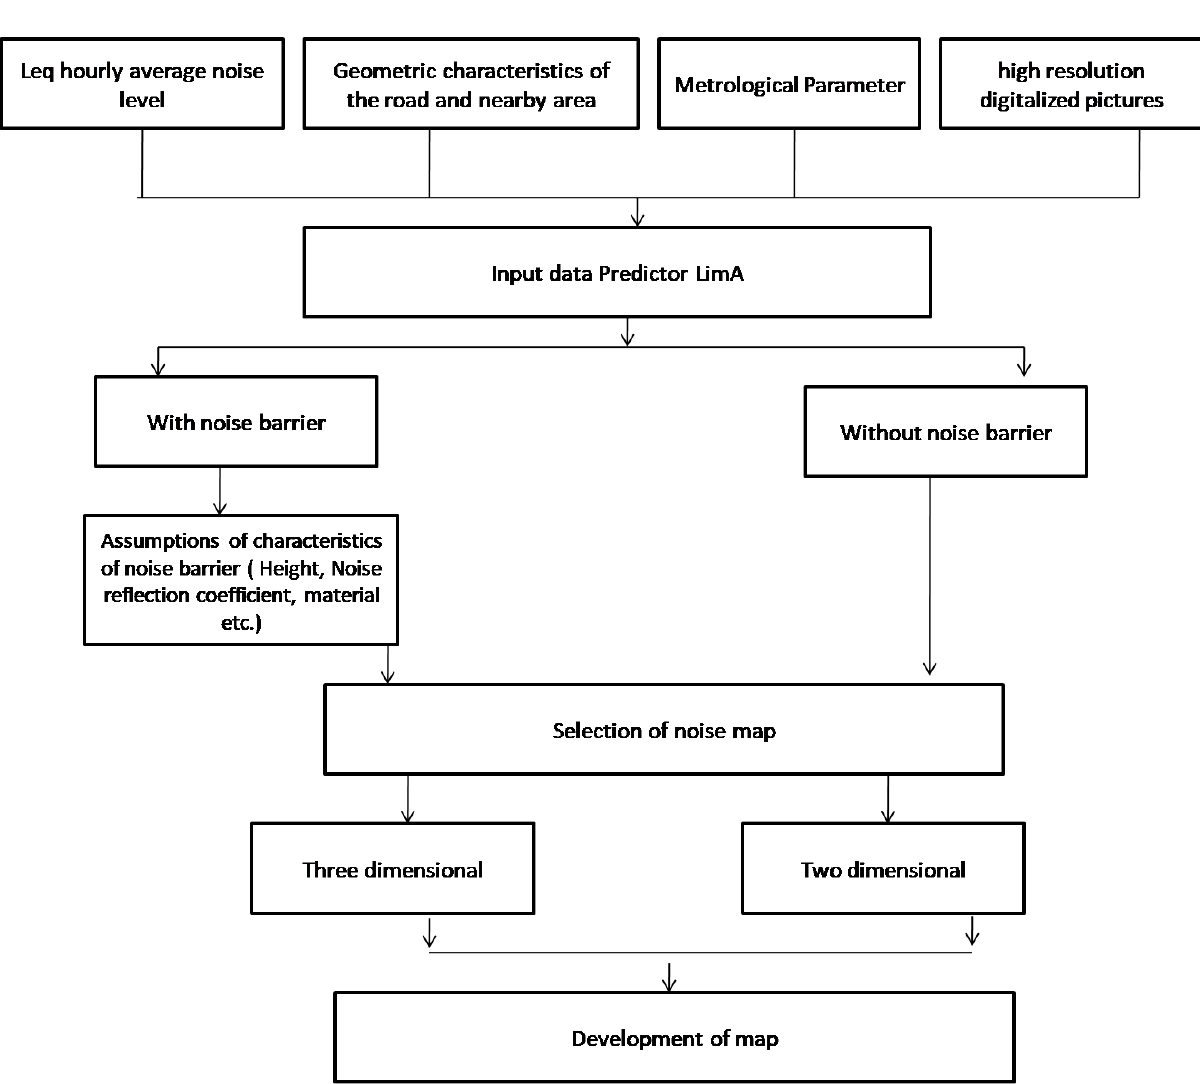
Figure 5: Noise mapping